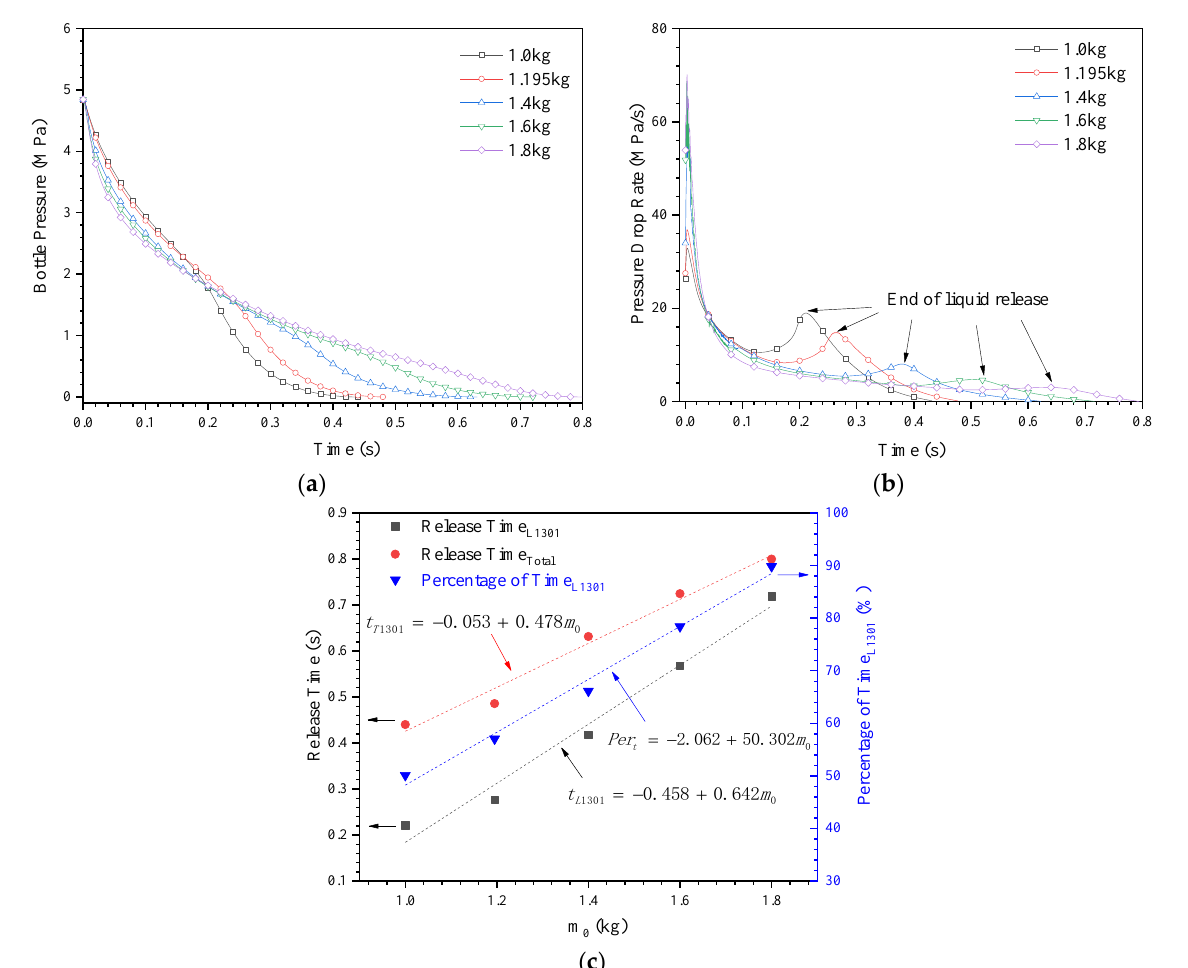
Figure 13. Bottle pressure and release time under different filling amounts: ( a ) bottle pressures; ( b ) bottle pressure-drop rate; ( c ) release time and liquid time percentage.